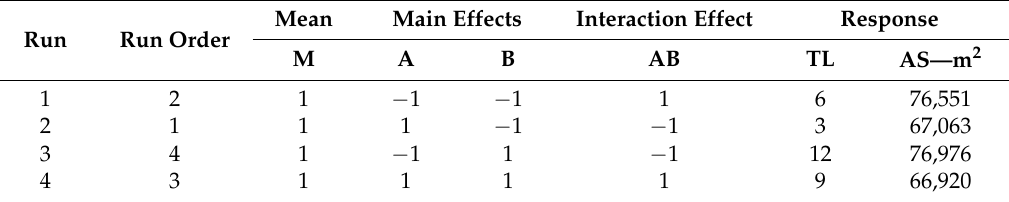
Table 12. Contrast matrix of the overall system.